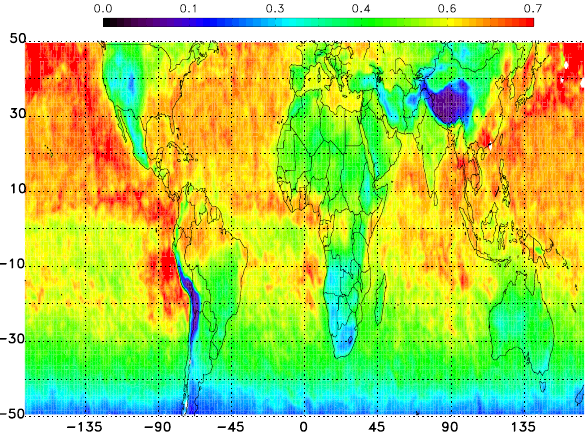
Fig. 6. Global distribution of the layer efficiency at 2.8km for June 2005 from OMI level 2 data for reflectivity less than 0.3. Only the pixel numbers 20 to 40 from each swath were